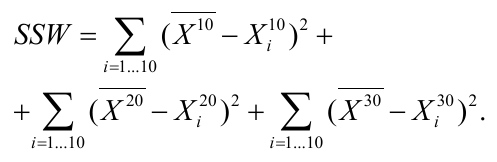
Table 1. Characteristics to input data